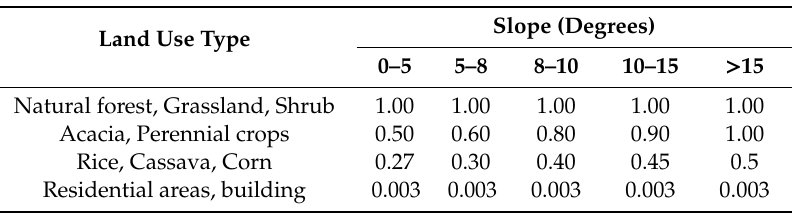
Table 3. p -Value based on slope and land use